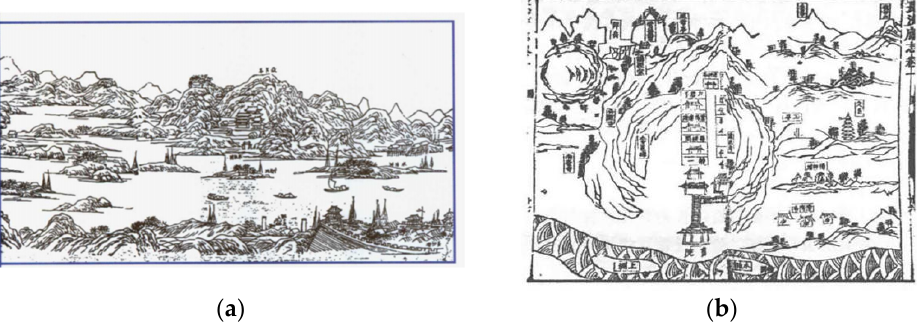
Figure 2. ( a ) Complete Map of the Early Qing Mountains in “The Chronicles of Southern Yue”; ( b ) the Yuelu Academy of the Ming time period from “The Chronicles of Southern Yue”.